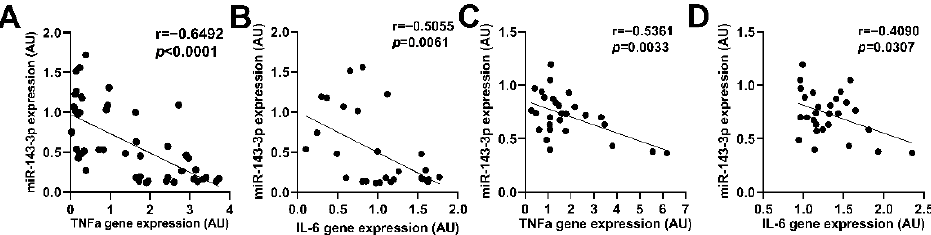
Figure 2. miR-143 was negatively correlated with the expression of inflammatory factors in the BAT. ( A , B ) Correlation between miR-143 expression and TNF α ( A ) or IL-6 ( B ) in the BAT of mice fed HFD for 0, 1, 3, 7, 14, 21 days (n = 48 and 28). ( C , D ) Correlation between miR-143 expression and TNF α ( C ) or IL-6 ( D ) in primary brown adipocytes treated with 0.2 µ g/mL LPS for 0, 12, 24, 48 h (n = 28). The correlation between miR-143 and IL-6 or TNF α was analyzed by GraphPad Prism 9.0.